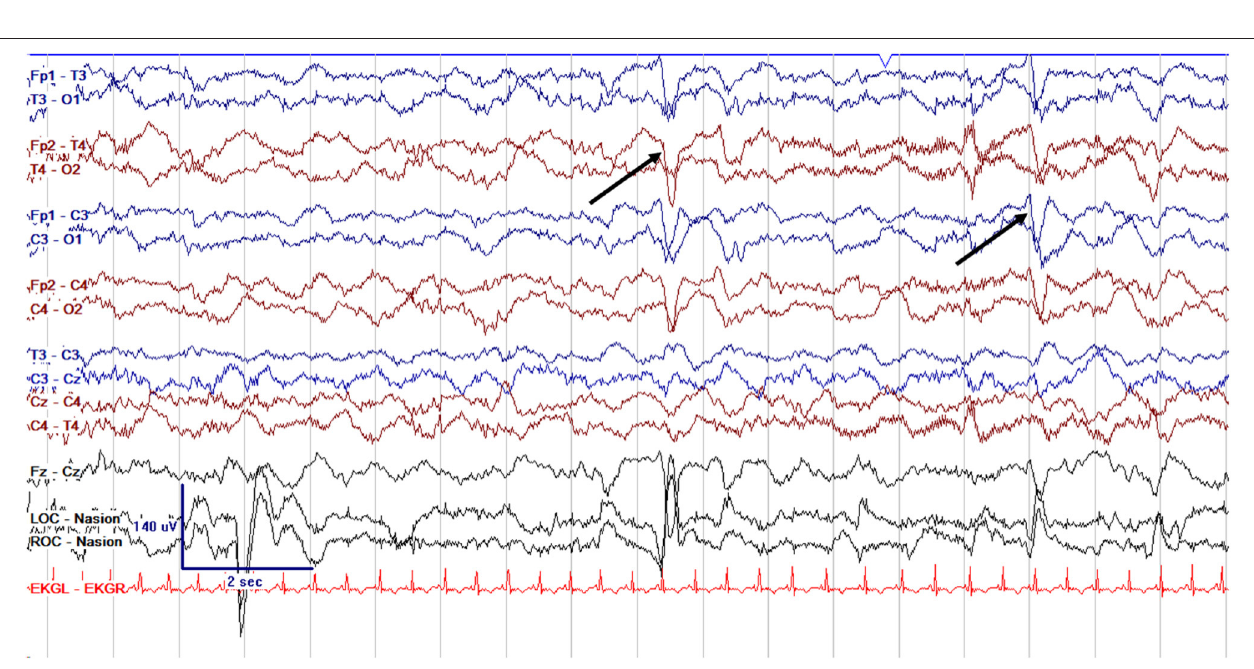
FIGURE 2 | Normal cEEG in a term neonate in the awake state, a 3 day old former 39 + 0 week GA (39 + 3 week PMA) with normal continuous activity of variable voltage and frequency with normal graphoelements (encoche frontales–normal frontal sharps, arrows).